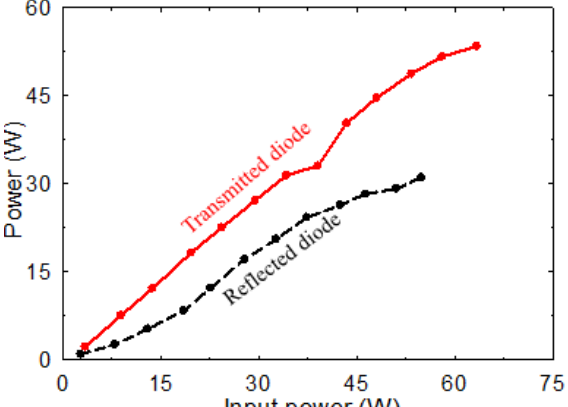
Figure 5. Reflected and transmitted pump power after VBG with 60-W diodes vs. power incident on the